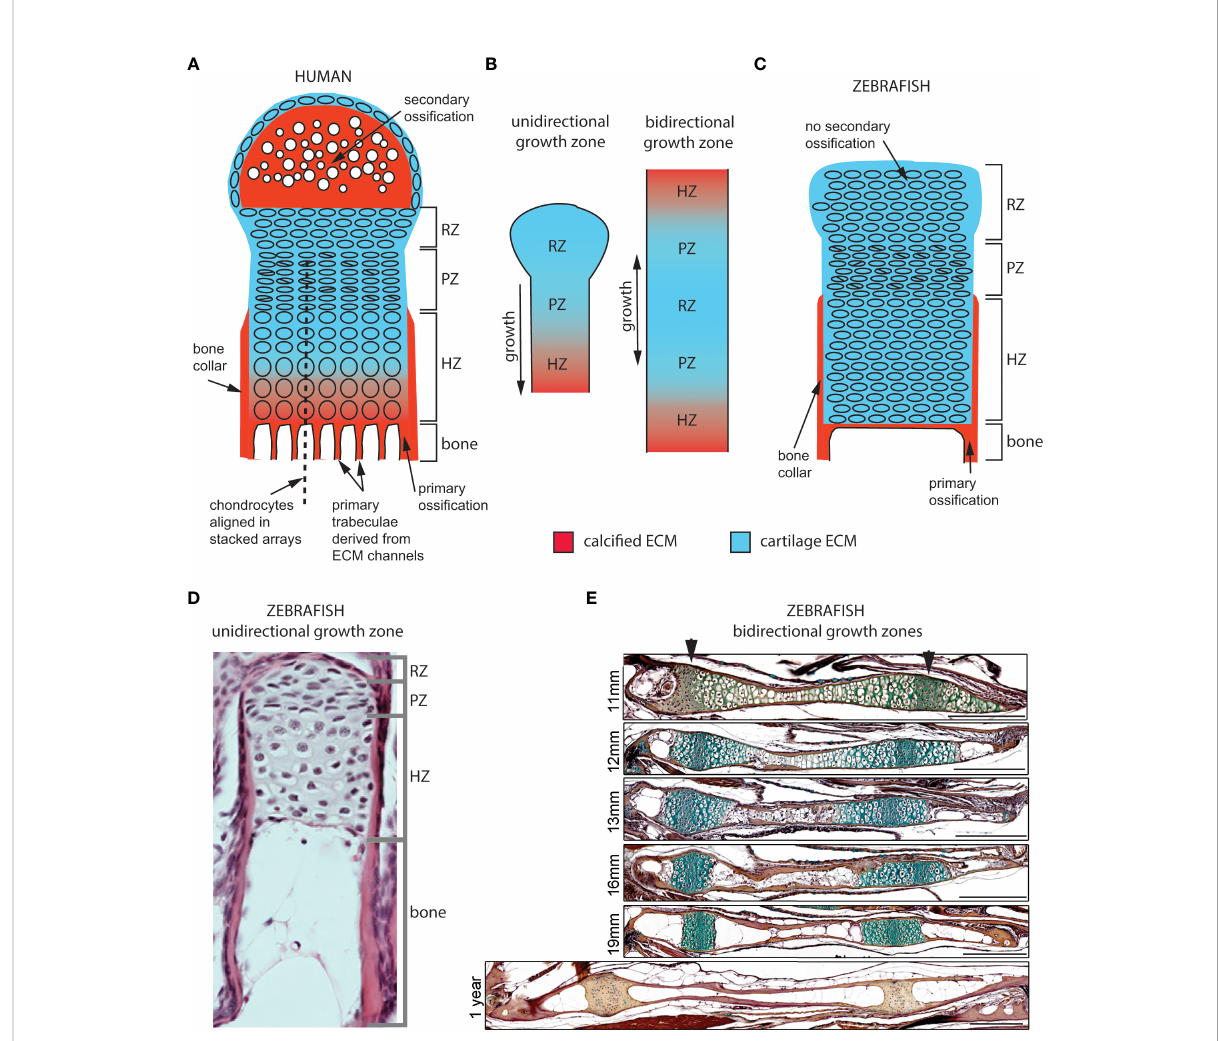
FIGURE 2 Cellular organization of epiphyseal and synchondroseal growth zones. (A) Human growth plate chondrocytes transition through resting-, proliferative- and hypertrophic zones (RZ, PZ, and HZ, respectively) before dying or transitioning to an osteoblast fate at the chondro-osseous junction. Cartilage cells stop dividing and enlarge in the hypertrophic zone. The bone collar forms a sheath around hypertrophic chondrocytes; the secondary ossi fi cation fl anks the growth plate distally. Primary bone trabeculae derived from extracellular matrix channels populate the bone cavity. (B) In unidirectional (epiphyseal) growth zones, the resting zone is distal to the proliferative zone, itself distal to the hypertrophic zone; this layout produces unidirectional growth. In bidirectional (synchondroseal) growth zones, the resting zone is fl anked by two proliferative zones and two hypertrophic zones in a mirror image organization; this layout produces bidirectional growth. (C) Stereotypical zebra fi sh unidirectional growth zone organization: chondrocytes transition through RZ, PZ and HZ, but they do not enlarge in the HZ. At the zebra fi sh resorption front, chondrocytes die or transition to either an osteocyte or adipocyte fate. A perichondral bone collar sheathes the zebra fi sh hypertrophic zone, but no secondary ossi fi cation is associated with zebra fi sh epiphyseal growth zones. Trabeculae are not observed in smaller teleosts such as zebra fi sh. (D) Histological section of zebra fi sh proximal radial showing unidirectional endochondral growth zone [originally published in (23)]. (E) Time series of maturation at two zebra fi sh bidirectional growth zones located within the ventral (left) and dorsal (right) ceratohyal synchondroses [originally published in (24)]. (scale bars = 50